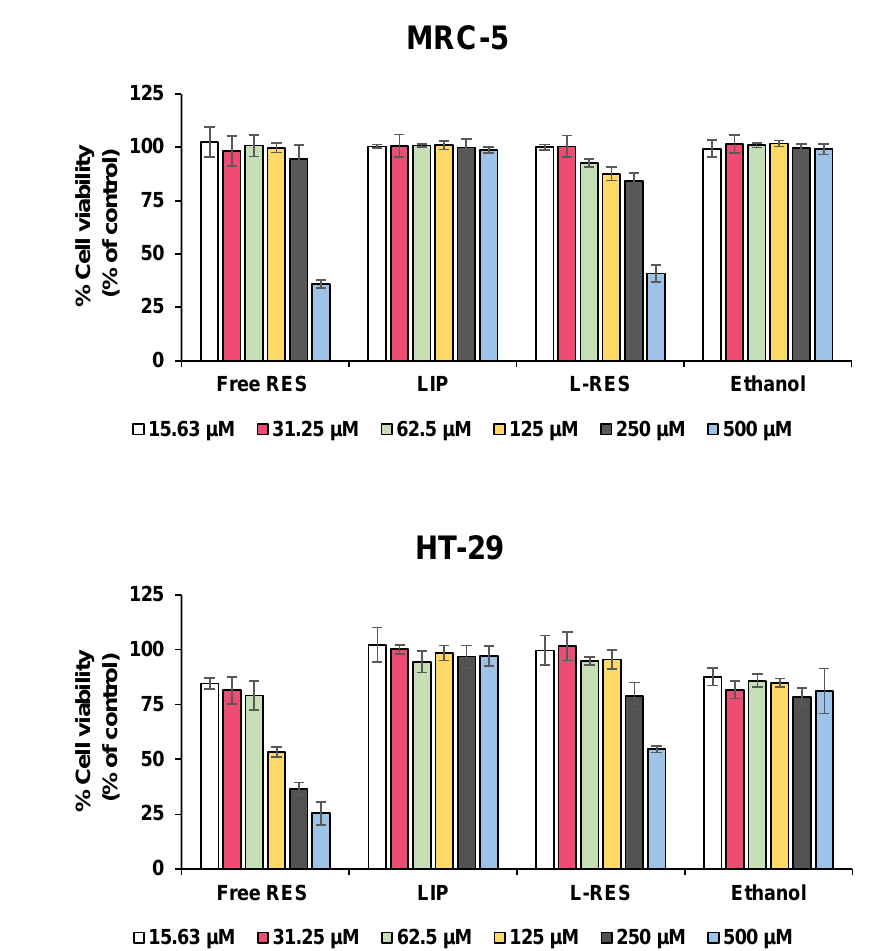
Figure 3. Cytotoxicity of RES, LIP, and L-RES against colorectal cancer and normal human fibroblast cell lines. ( A ) Cell viability of MRC-5 cells. ( B ) HT-29 cells in monolayer were exposed to RES, LIP, and L-RES for 24 h. MTT assay was used to analyze cell viability. Data are shown as representative data of two independent experiments, and error bars represent